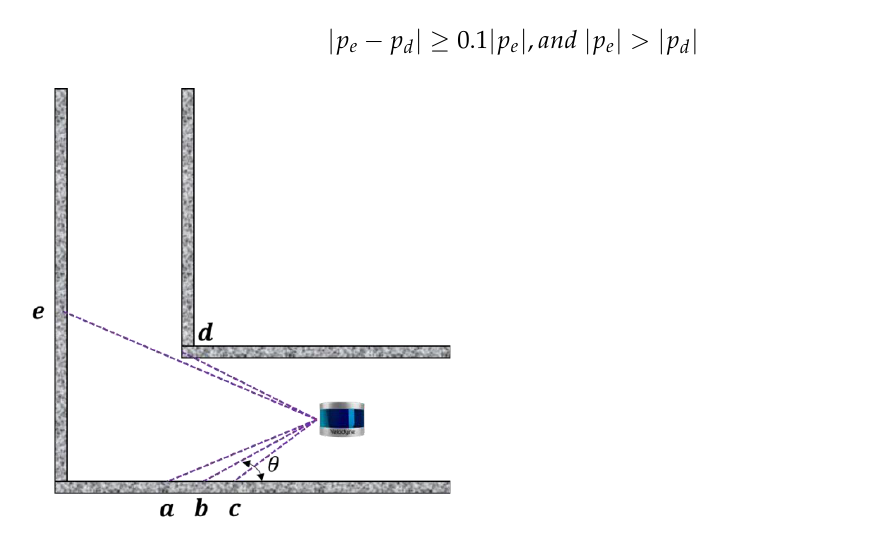
Figure 9. Graphics of the incidence angle reflection angle.